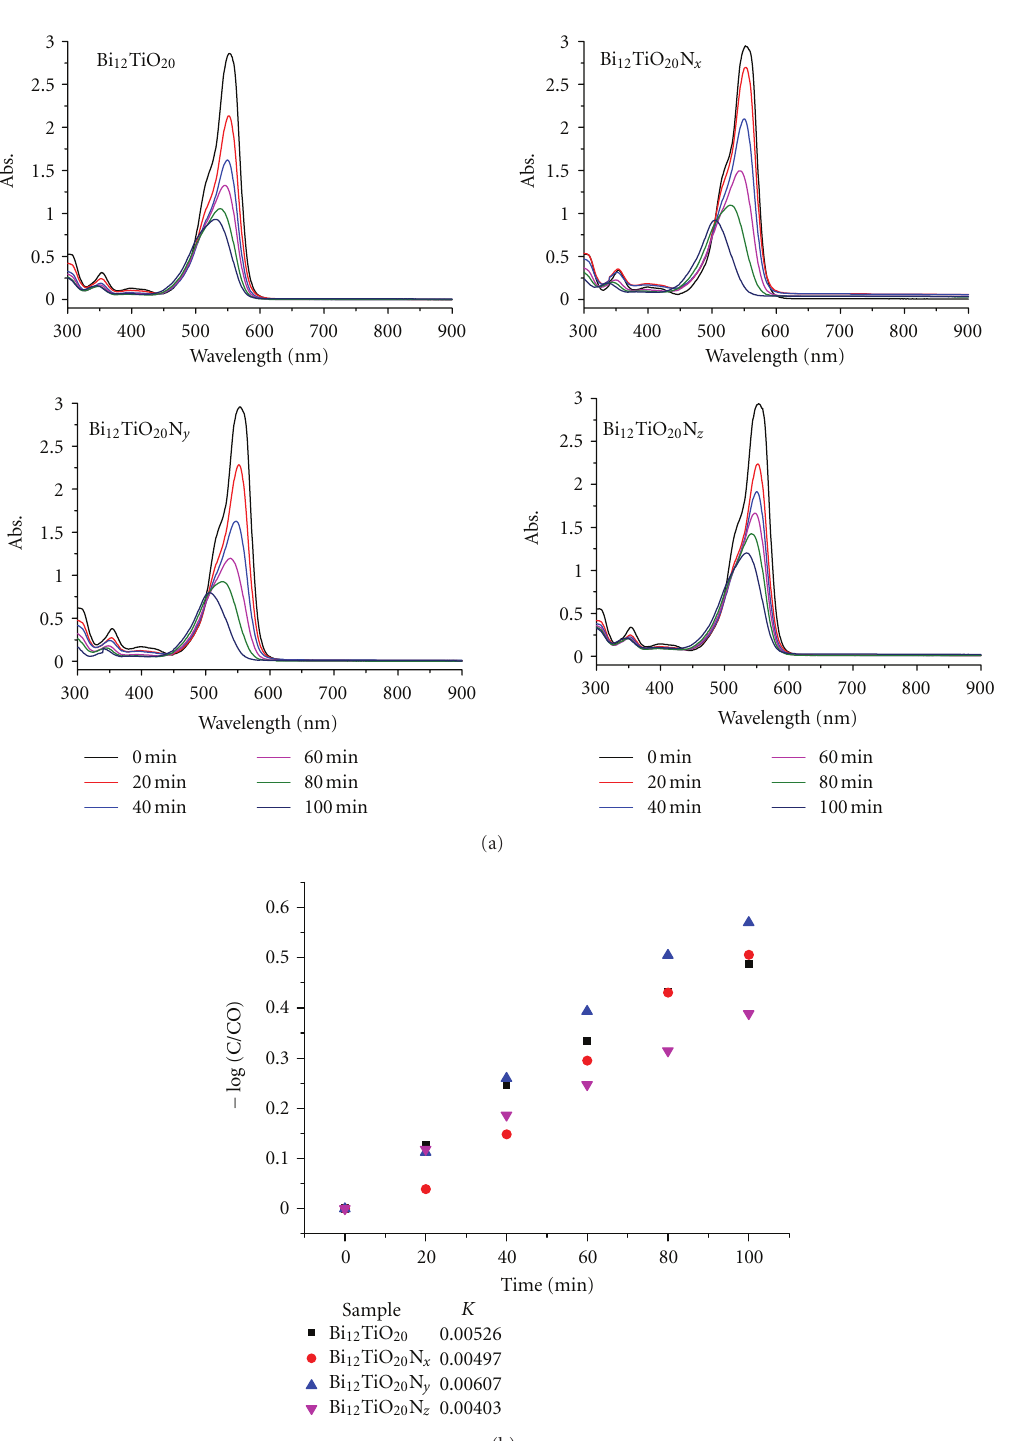
Figure 5: Photocatalytic decomposition of RhB by undoped and nitrogen-doped Bi 12 TiO 20 photocatalysts: (a) absorption spectra decay of RhB via time; (b) decomposition activity of